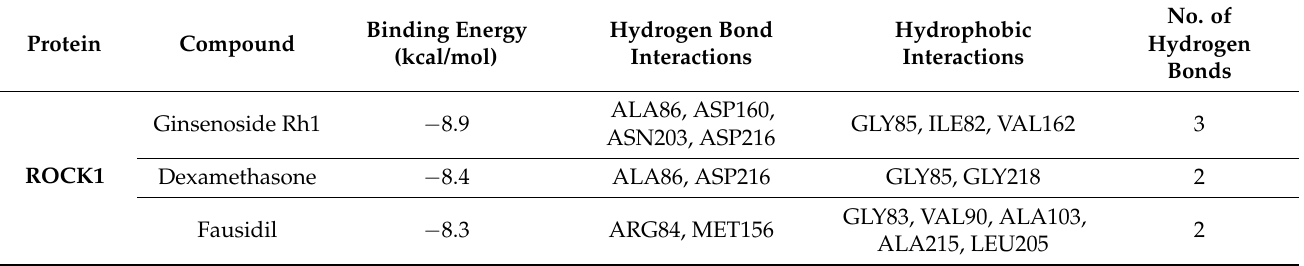
Table 4. Interaction of ginsenoside Rh1 and control drugs with amino acid residue of ROCK1 & RhoA.